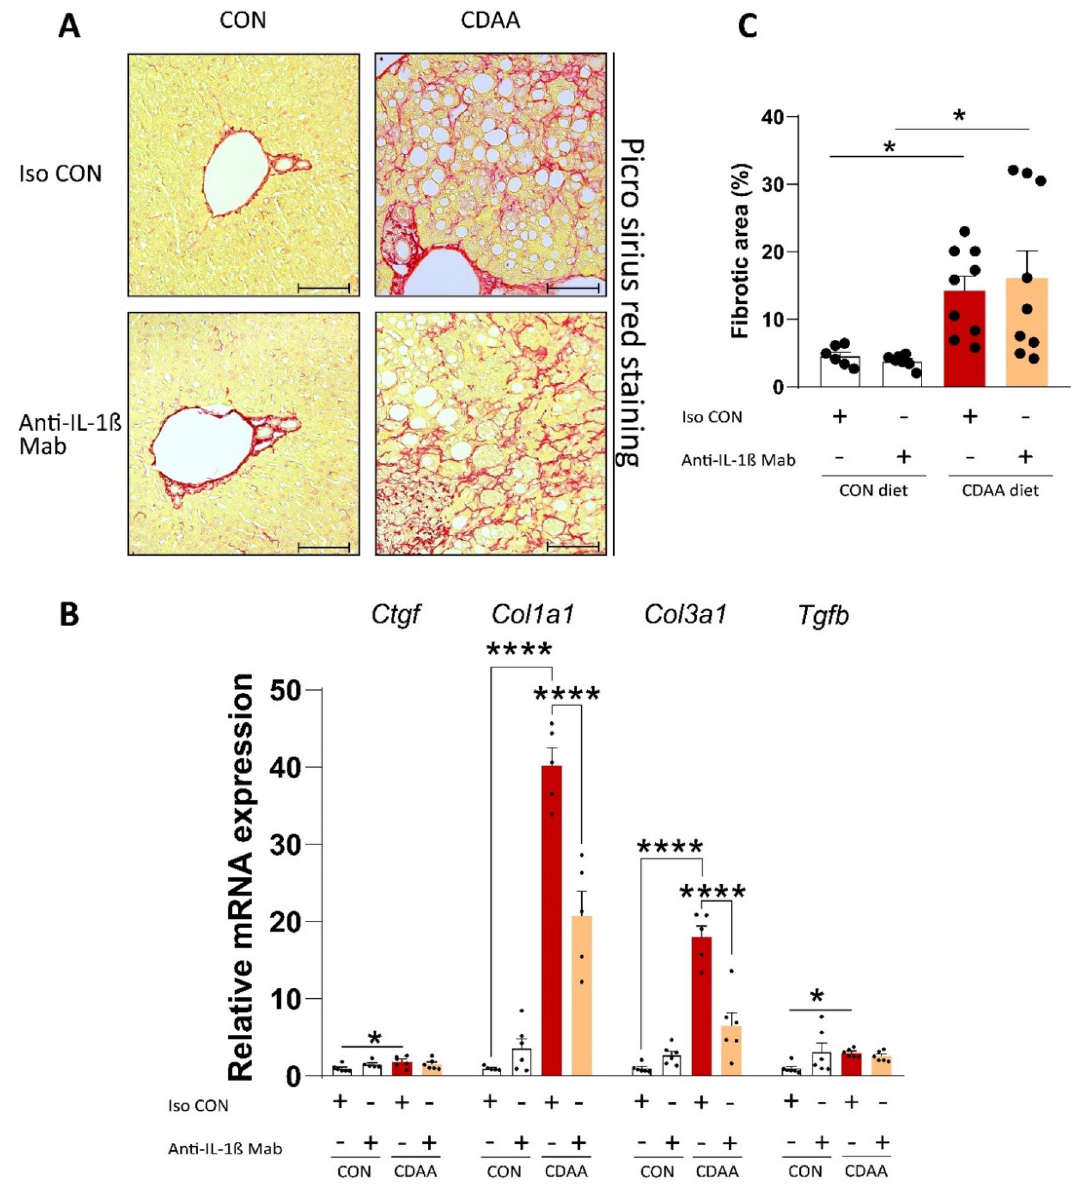
Figure 2. Histological and molecular assessment of hepatic fibrosis. Evaluation of hepatic fibrosis by picrosirius-red staining ( A ) (n = 6–9/group). Analysis of major pro-fibrotic genes, normalized to Ppia , with qRT-PCR ( B ) (n = 5–6/group). Quantification of overall fibrosis ( C ) (n = 6–9/group). CDAA, Choline Deficient L-Amino Acid-defined diet; CON, control diet; Iso CON, isotype control; Anti-IL-1β, anti-interleukin-1β monoclonal antibody. Scale bar shows 100 µm. Two-way ANOVA, Fisher’s LSD post hoc test, * P < 0.05, ** P < 0.01, *** P <